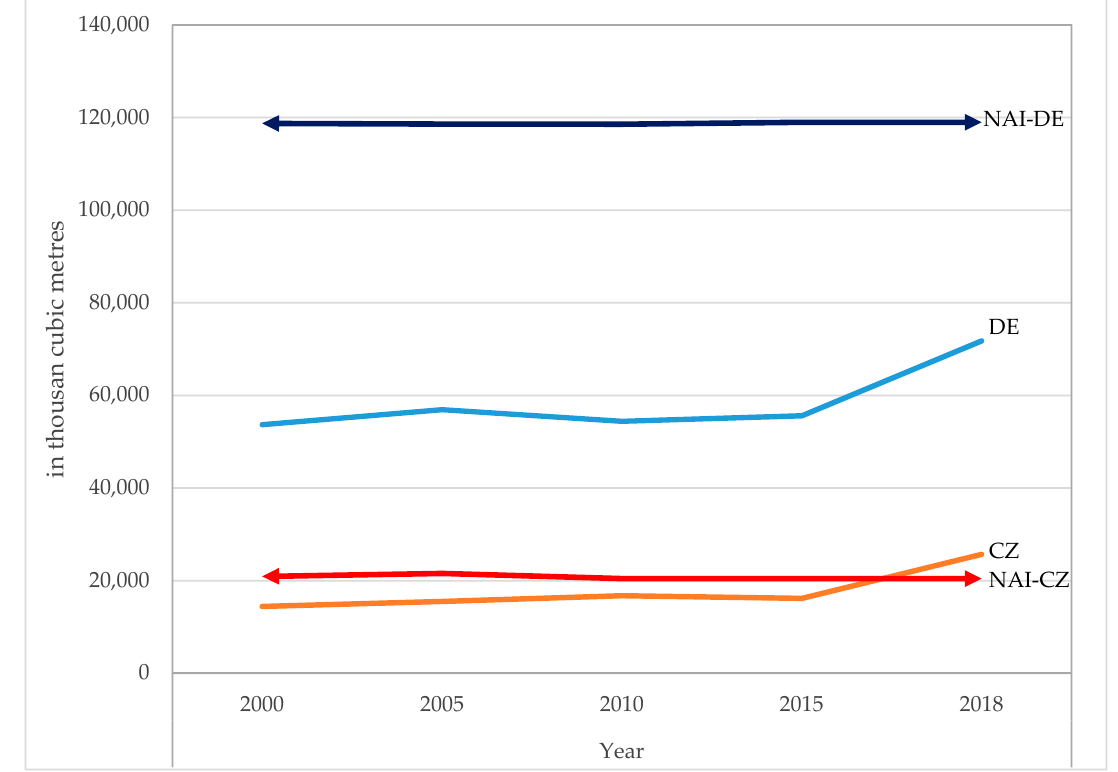
Figure 2. Total roundwood production and net annual increment (NAI) in Germany (DE) and the Czech Republic (CZ) (2000–2018) [41–43].